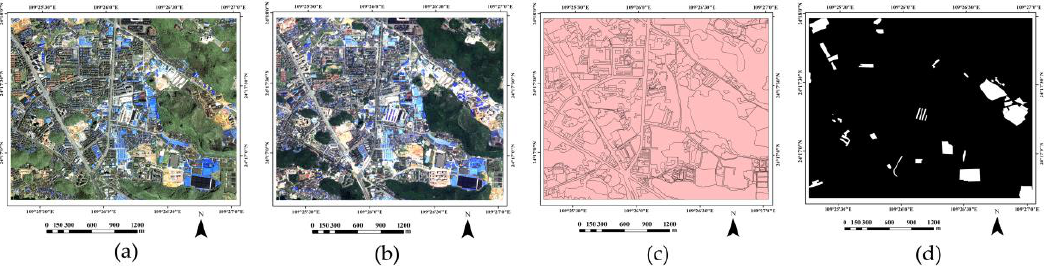
Figure 6. The first experimental dataset (DS1). ( a ) Image acquired on 13 April 2015; ( b )